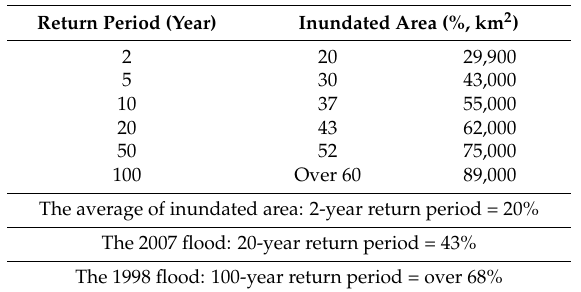
Table 2. Return periods with corresponding inundated areas in Bangladesh